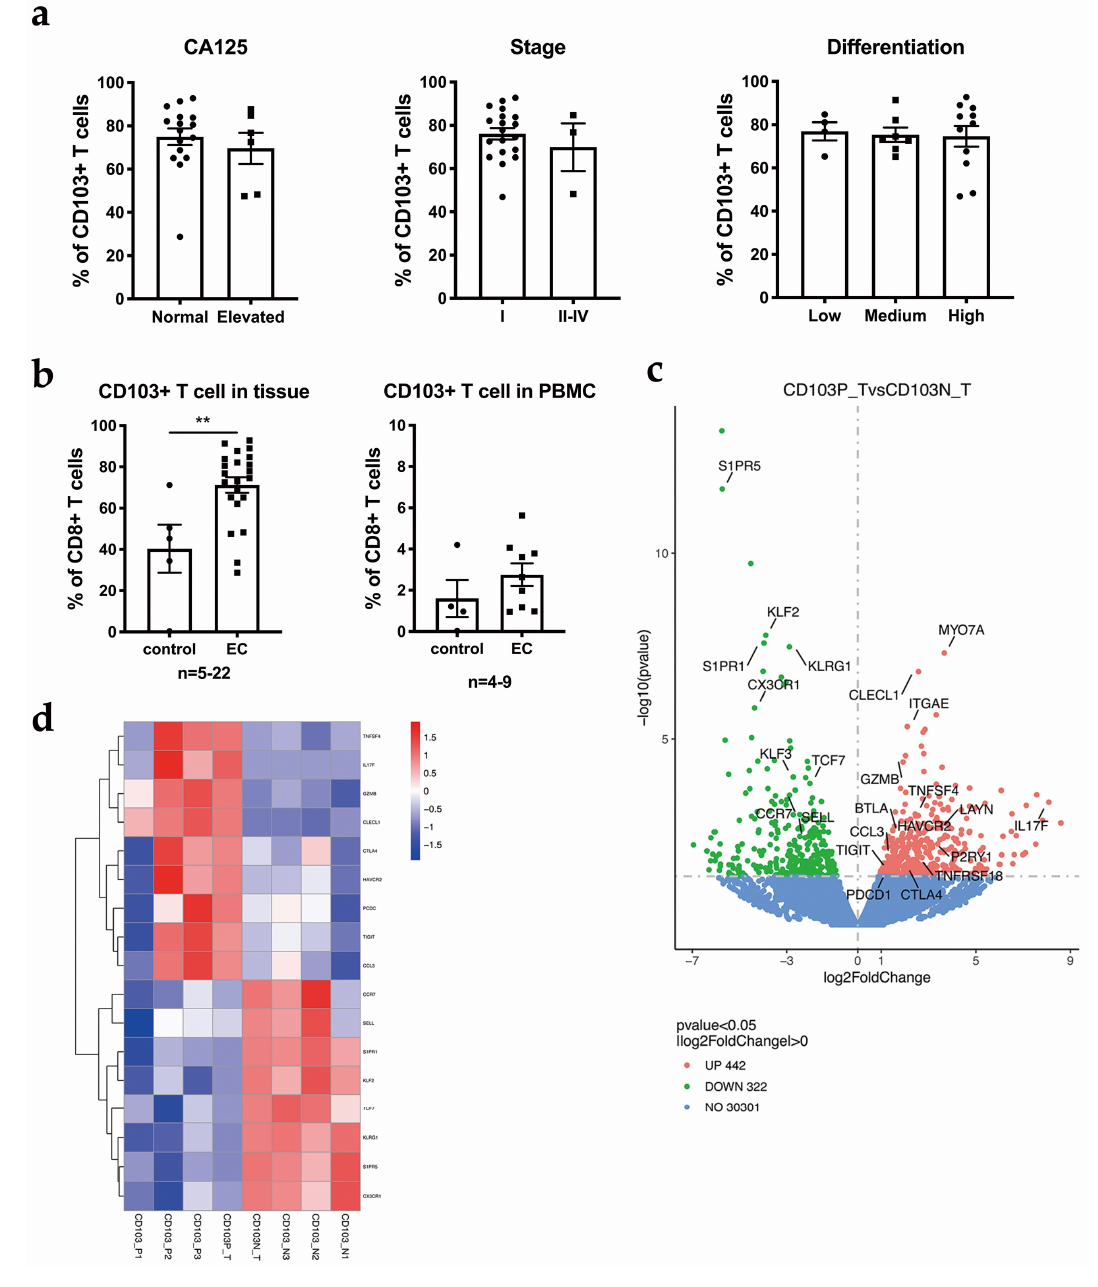
Figure 4. CD103+ CD8+ T cells are the main components of CD8+ T cells: ( a ) The relationship between the abundance of CD103+ CD8+ T cells and clinical features, including CA125 levels, tumor stage and tumor differentiation. ( b ) In patients with EC, the percentage of CD103+ CD8+ T cells among all CD8+ T cells was significantly increased in TILs compared to that in the POP controls. However, the percentage of CD103+ CD8+ T cells among all CD8+ T cells was not significantly increased in PBMCs from patients with EC compared to PBMCs from POP control. ( c ) The volcano plot displays significantly differentially expressed genes between CD103+ (CD103P) and CD103 − (CD103N) in flow-sorted CD8+ T cells from n = 3 independent patients. Unadjusted 𝑝 values are shown. Upregulated genes in CD103+ CD8+ T cells are marked in red, and downregulated genes are marked in green. ( d ) A heatmap is shown comparing gene signatures derived from the bulk RNA-seq analysis (CD103+ versus CD103 − ) of three individuals. p value compares the indicated group using an unpaired t-test (two-tailed). 𝑝 < 0.01 (**).